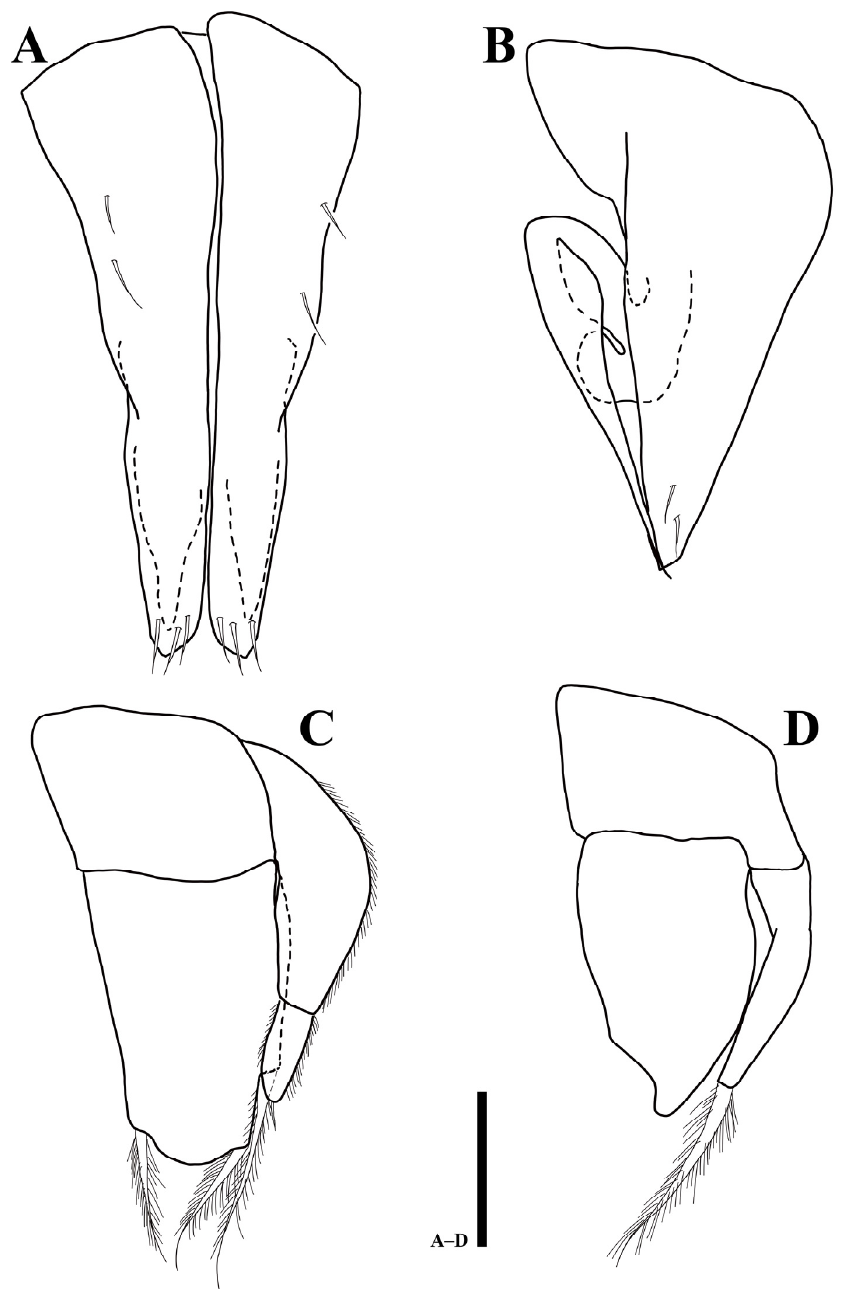
Figure 7. Uromunna mundongensis sp. n. holotype male: ( A ) pleopod 1; ( B ) pleopod 2; ( C ) pleopod 3; ( D ) pleopod 4. Scale bar = 100 μ m.